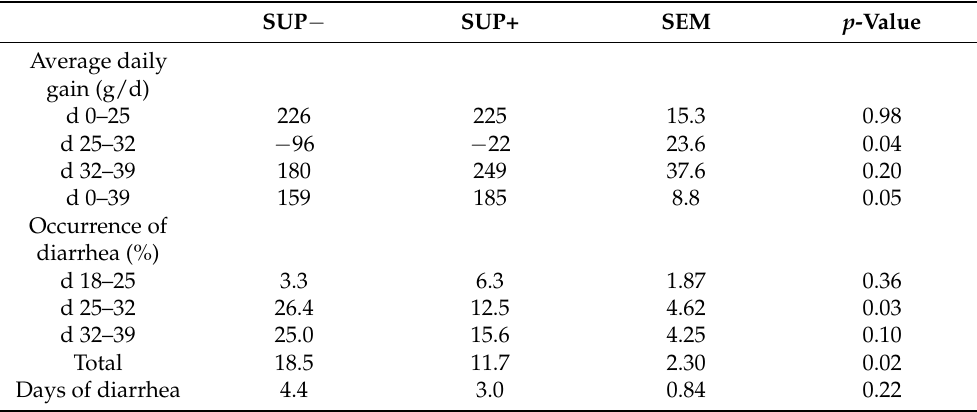
Table 1. Growth performance and occurrence of diarrhea in piglets from the unsupplemented (SUP − ) and supplemented (SUP+) groups. The supplement, given at birth, consisted of a mixture of probiotics, prebiotics, immunoglobulins, vitamins, and selenium. SUP